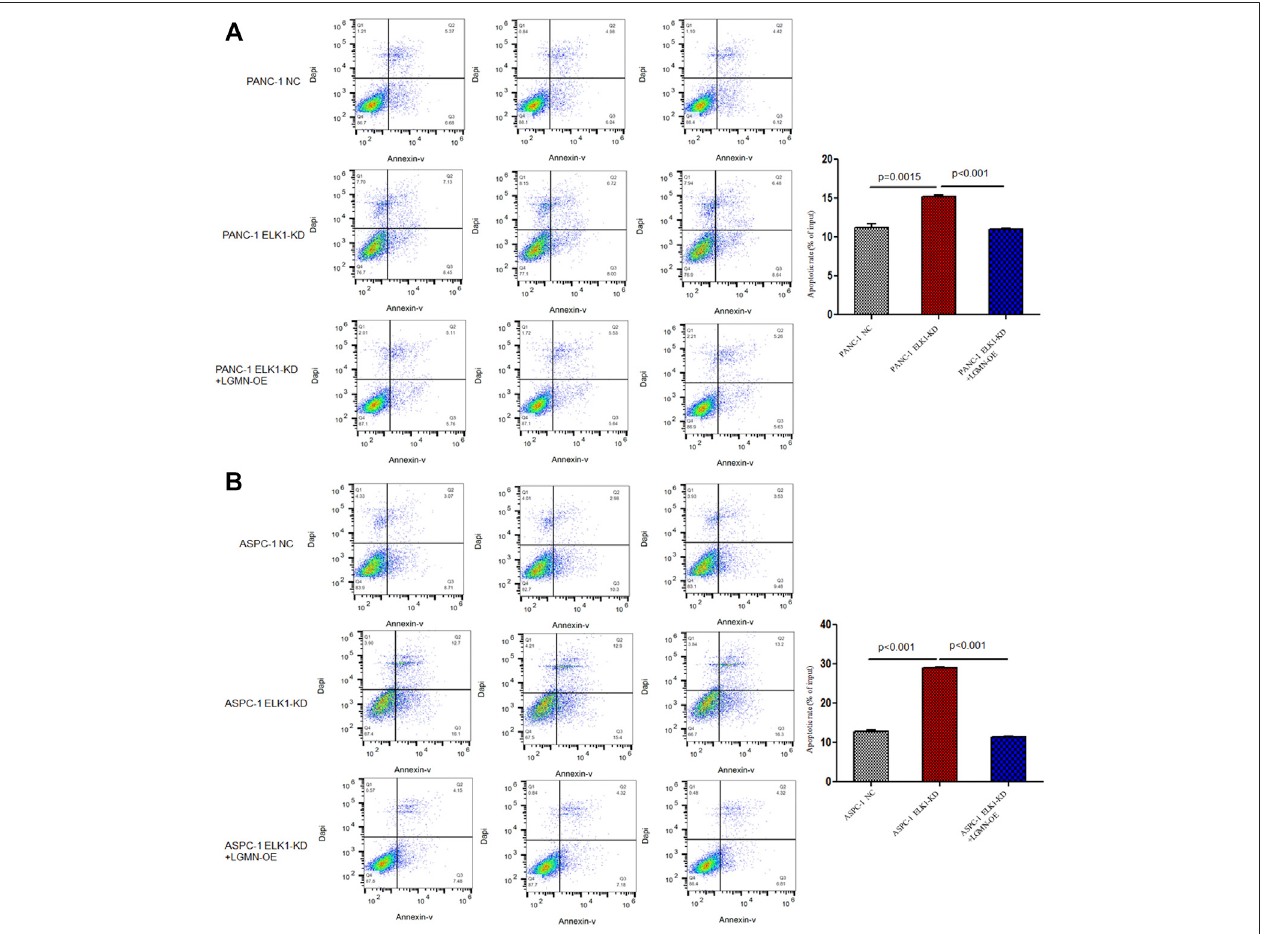
FIGURE 4 | ELK1promoted pancreatic cancer cells survival via LGMN. (A , B) FACSapoptoticanalysis ofPANC-1and ASPC-1cells with ELK1 knocked down aswell as LGMNrescued.* p (cid:1) 0.0015,** p < 0.001betweenELK1-KDgroupandcontrolgroup,ELK1-KDgroupandELK1-KD+LGMN-OEgroupinPANC-1cells.* p < 0.001,** p < 0.001, between ELK1-KD group and control group, ELK1-KD group and ELK1-KD+LGMN-OE group in ASPC-1